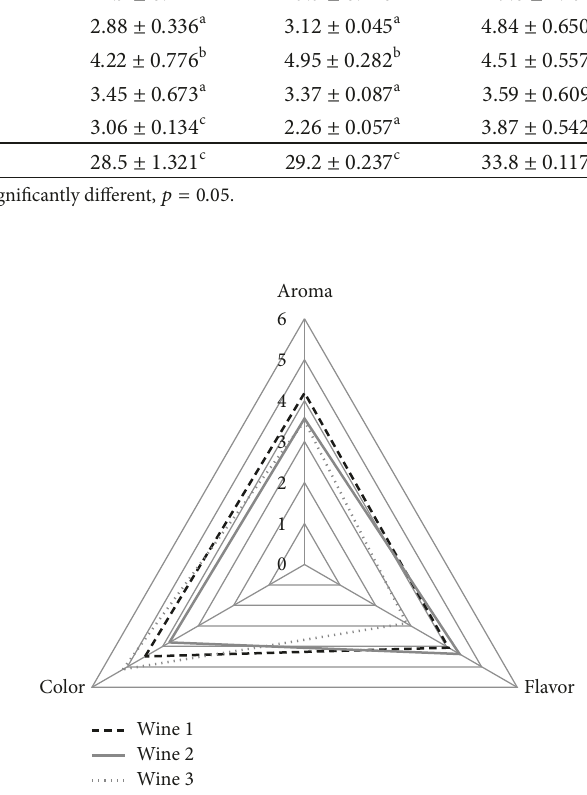
Figure 4: Sensory evaluation of the obtained